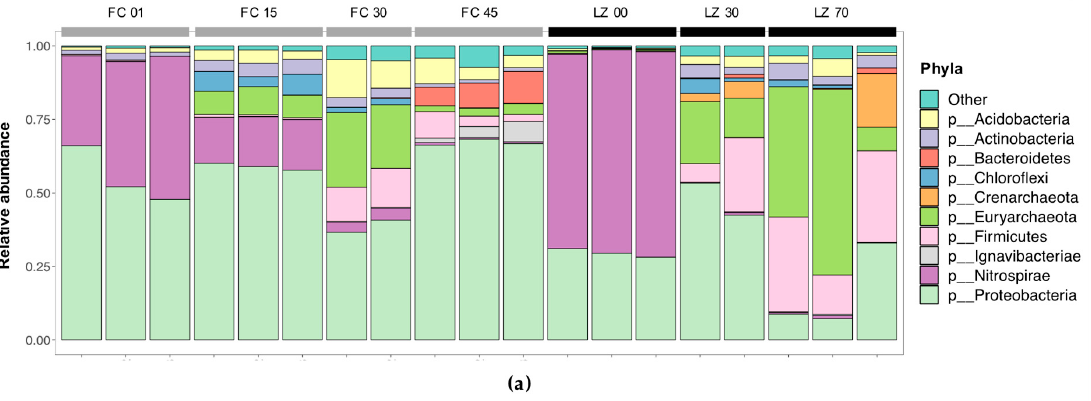
Figure 7. ( a ) Phylum-level composition in replicate samples of Filón Centro (FC, grey bars) and La Zarza (LZ, black bars) expressed as relative read abundance; ( b ) relative read abundance heatmap of the top 30 genera in individual replicates obtained per site, p_, c_, o_, f_, and g_ denote phylum-, class-, order-, family- and genus-level assignment of ESVs, respectively.